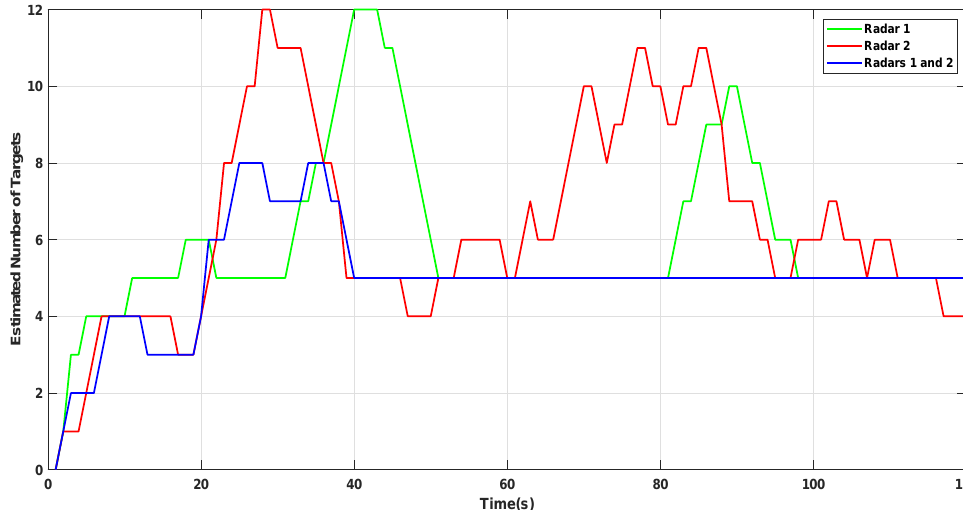
Figure 9. The number of estimated targets by individual trackers, and merged.